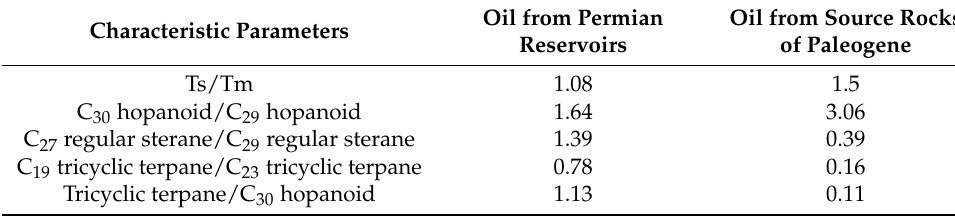
Figure 10. Gas chromatography – mass spectrometry of crude oil of Permian reservoirs and coal-measure source rocks in the Wumaying buried hill. Table 2. Characteristic parameters of oil from coal measures and from Paleogene source rocks.